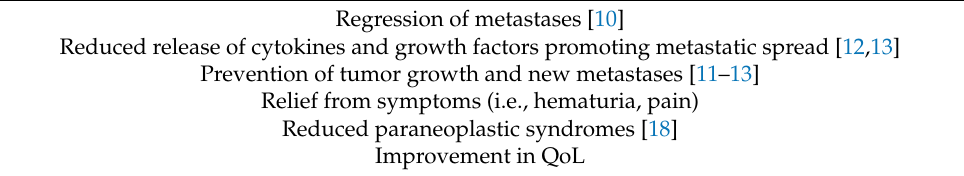
Regression of metastases